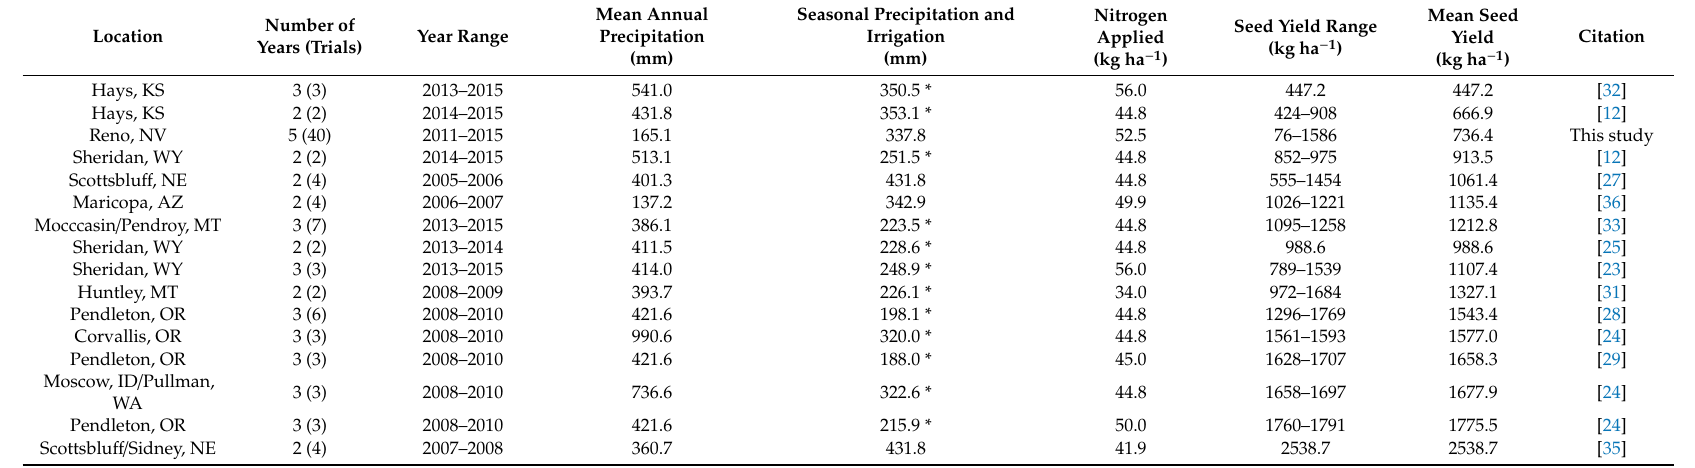
Table 9. Mean seed yield of the eight C. sativa cultivars grown in Reno, Nevada, 2011–2015 (this study), compared to other field